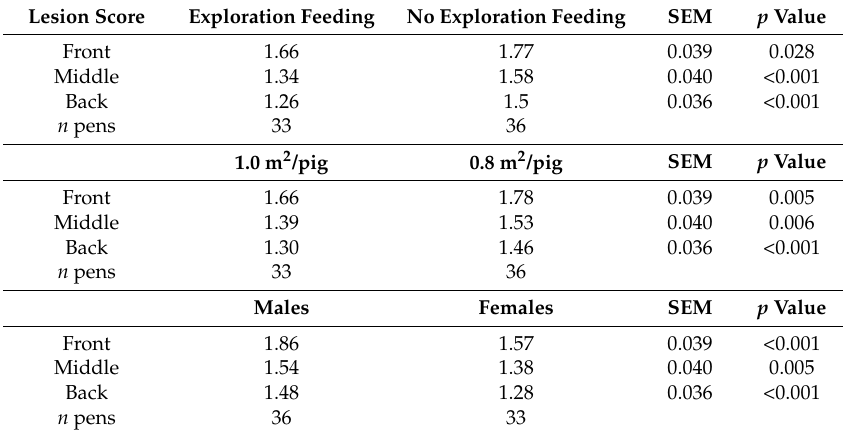
Table 1. Mean skin lesion scores (0–5) at the front, middle and back of the pigs related to the main treatment factors with SEM (Standard Error of the Mean) and p value for 64 pens in total. Lesion Score Exploration Feeding No Exploration Feeding SEM p Value